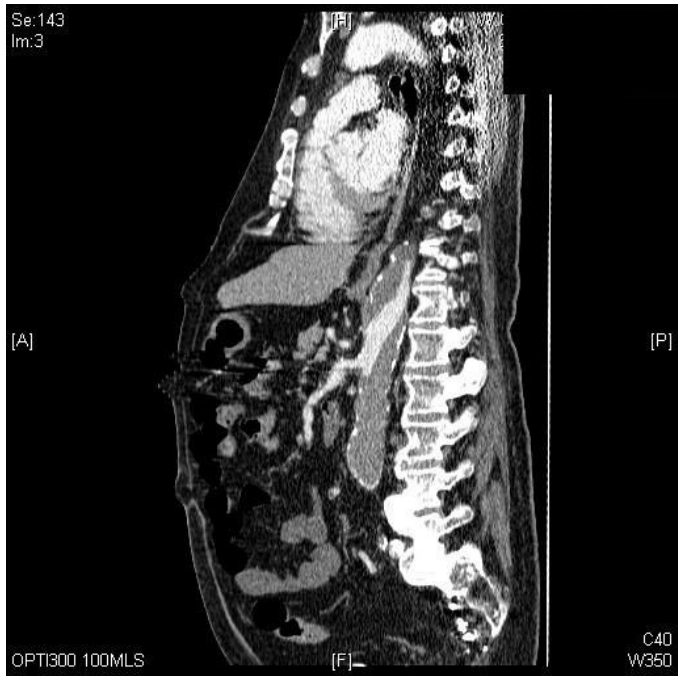
FIGURE 2. Contrast-enhanced CT of abdomen (sagittal reconstruction) shows dissection of abdominal aorta and thrombus in false lumen. The thrombosed aortic lumen expanded progressively to the expense of the perfused aortic